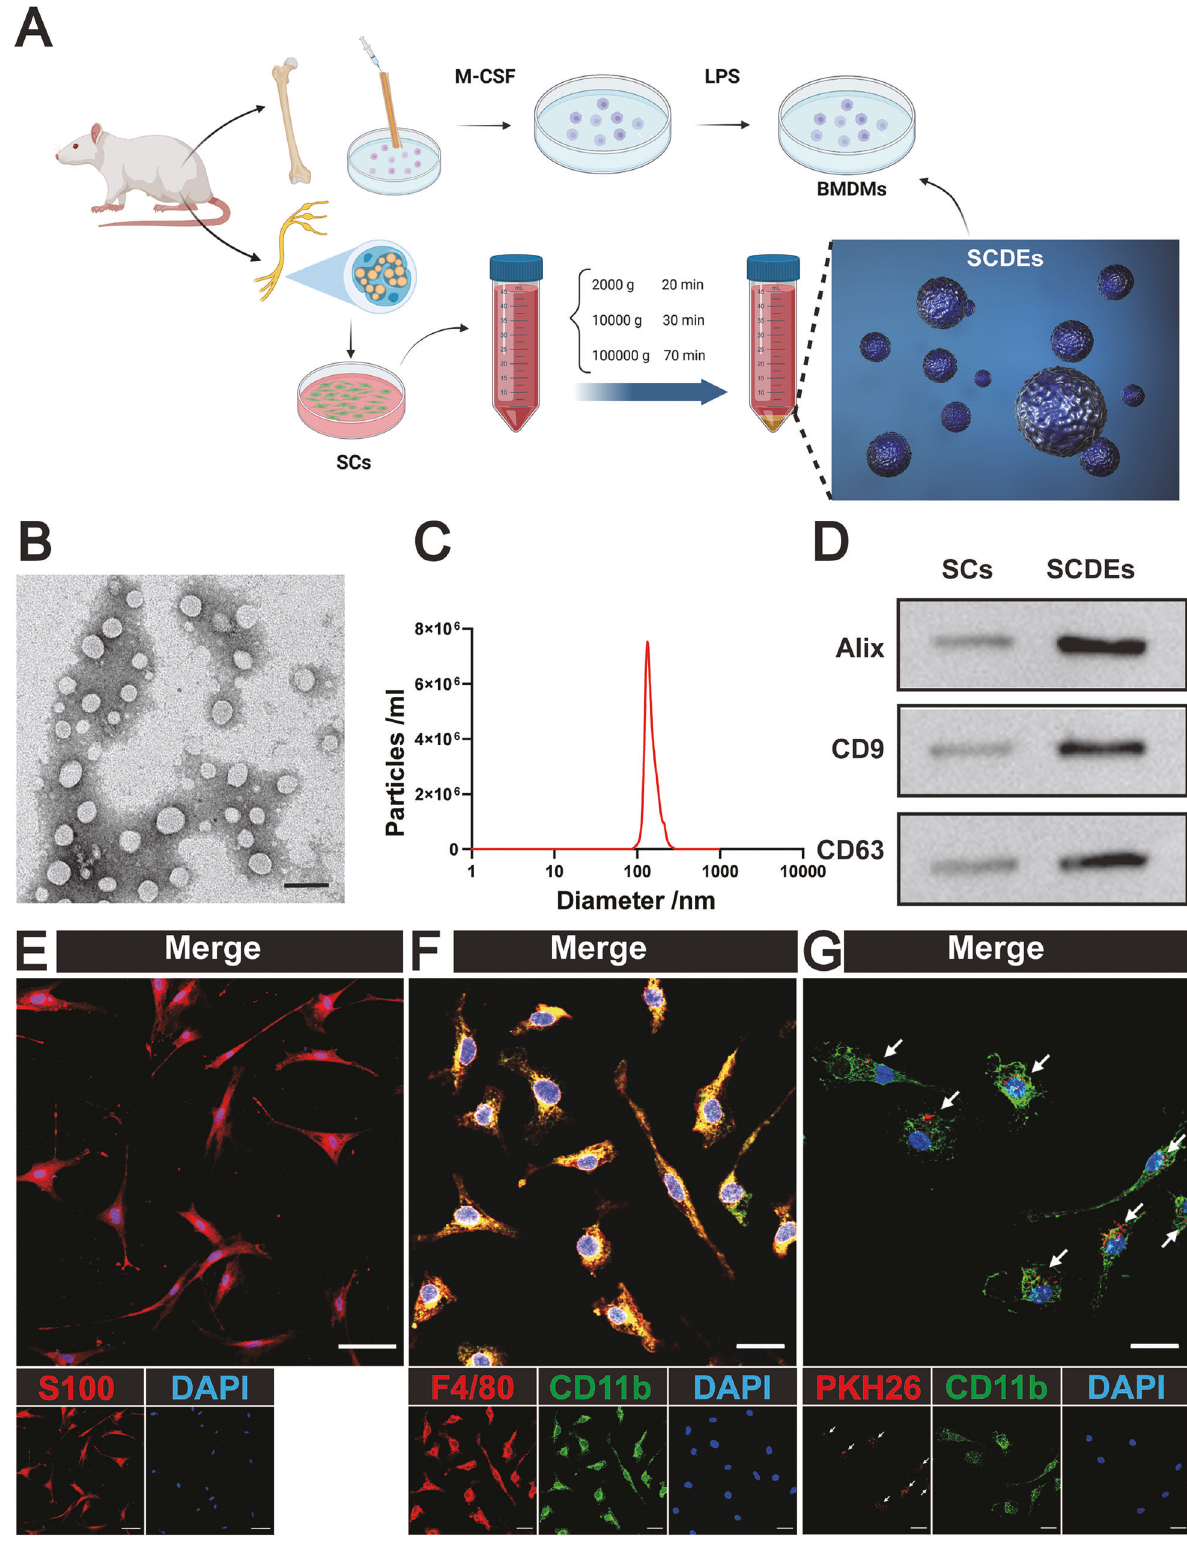
Fig. 1 Identi fi cation and uptake of SCDEs. A Schematic diagram of BMDMs and SCDEs. B Morphology of SCDEs under TEM. Scale bars: 100 nm. C The diameter distribution of SCDEs. D Western blot analysis of the positive expression of Alix, CD9, and CD63 in SCDEs. E Representative images of S100 (red). Nuclei were labeled with DAPI (blue). Scale bars: 20 µm. F Representative images of F4/80 (red) and CD11b (green). Nuclei were labeled with DAPI (blue). Scale bars: 20 µm. G Representative images of PKH26 (red)-labeled SCDEs absorbed by BMDMs. Nuclei were labeled with DAPI (blue). Scale bars: 20